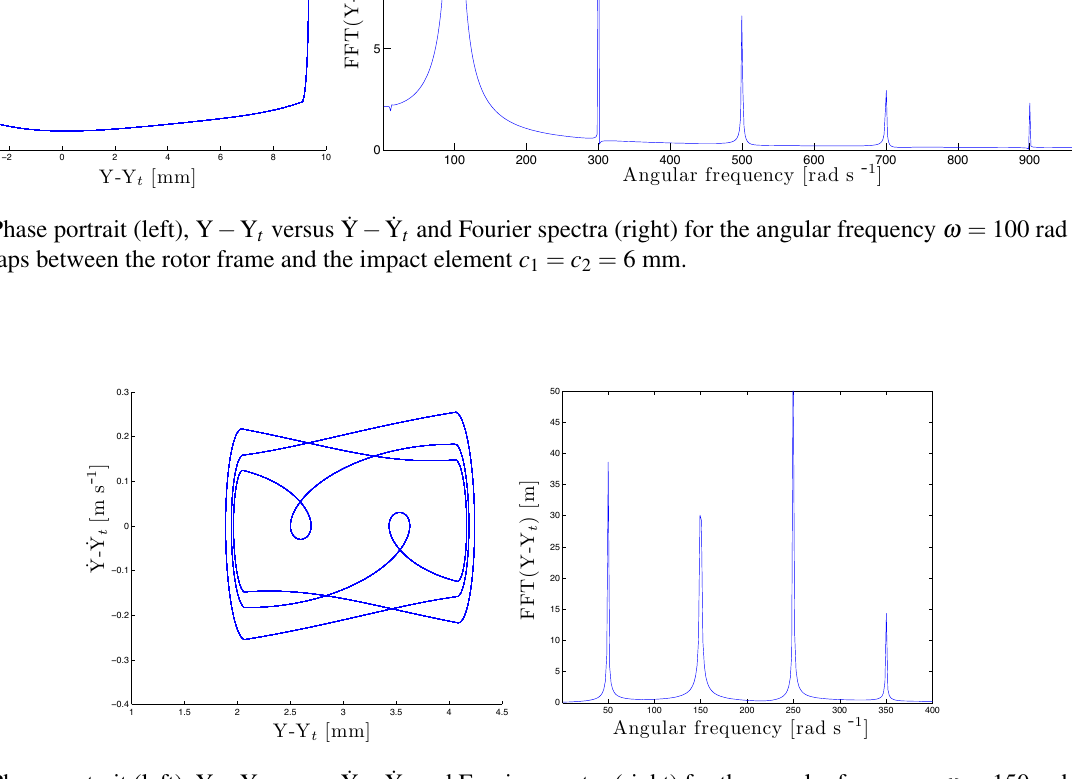
Fig. 16 Phase portrait (left), Y − Y t versus ˙Y − ˙Y t and Fourier spectra (right) for the angular frequency ω = 150 rad s − 1 and the gaps between the rotor frame and the impact element c 1 = c 2 = 1 mm.